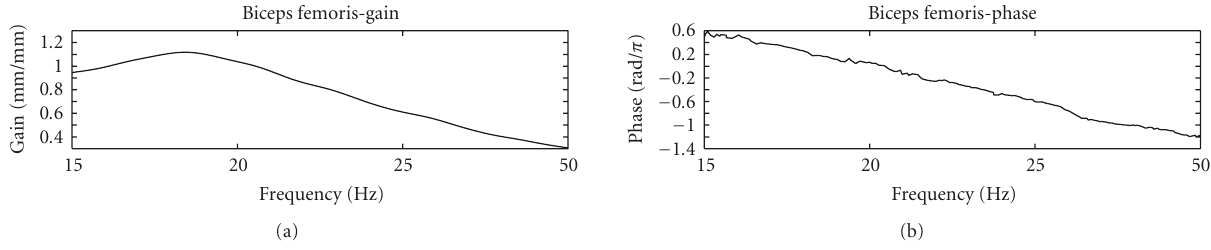
Variations of the mentioned parameters modifies the kine- matic chain, through which mechanical vibration propagates into the body, altering muscle local mechanical